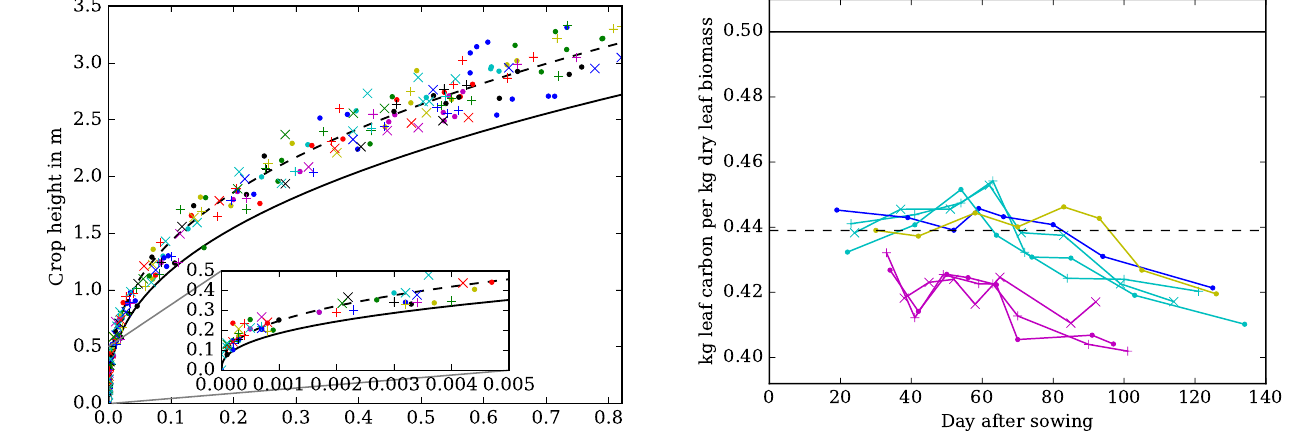
Figure 5. Crop height against dry stem biomass (including re- serves). Crop height against dry stem biomass (including reserves). Dots, vertical crosses (+) and diagonal crosses (x) are US-Ne1, US- Ne2 and US-Ne3 observations respectively. Solid line shows the fit using parameters from Osborne et al. (2015) ( λ = 0 . 4, κ (cid:48) = 3 . 06) and dashed line shows a tuned fit ( λ = 0 . 38, κ (cid:48) = 3 . 43). Only points up until the maximum stem biomass for that site in that year are plotted.